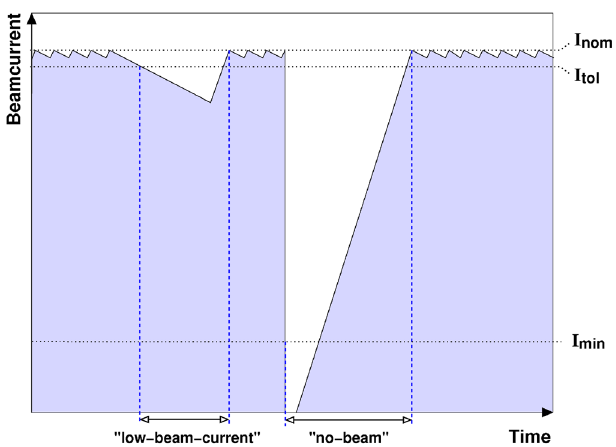
FIG. 1. A “ no-beam ” failure starts when the beam current drops below the current I ; a “ low beam current ” already starts below min the current limit I . Both modes stop when the nominal beam tol current I is nom